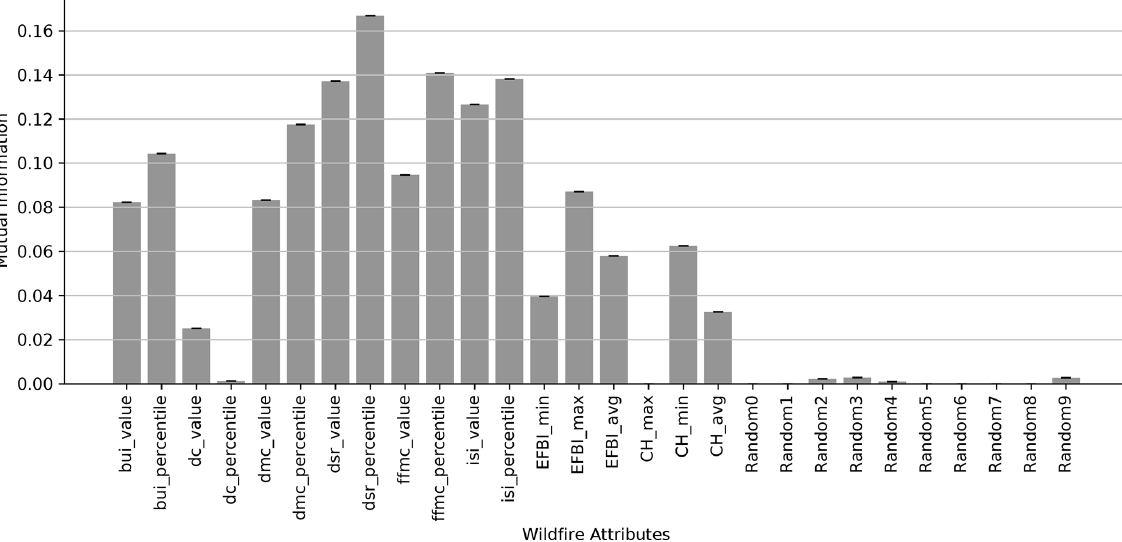
Figure 4. Mutual information of the different attributes gathered for each fire regarding their tag as fast or slow fires. CH: